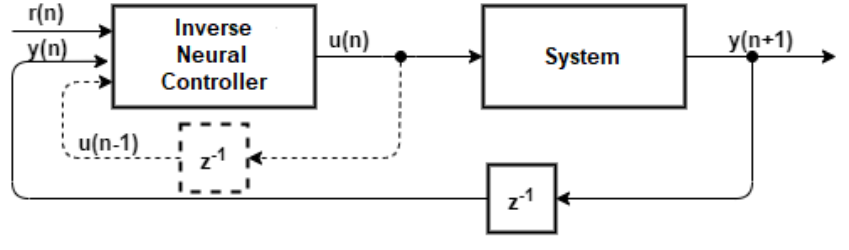
Figure 15. Inverse model controller diagram.